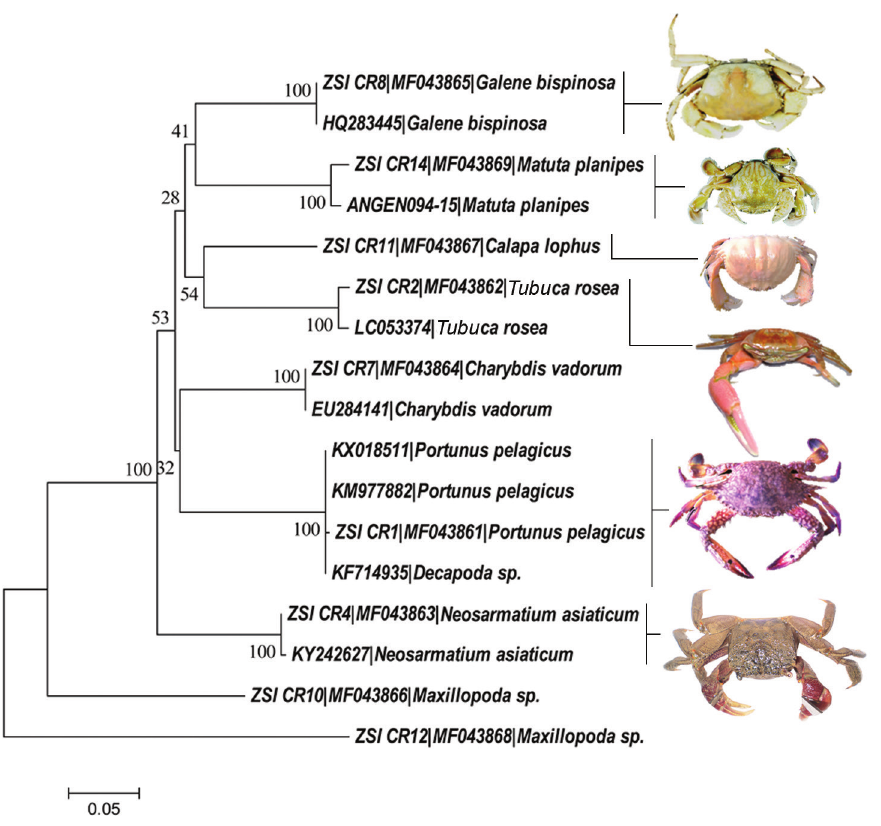
Figure 2: Neighbour-Joining tree of the studied crab species. Bootstrap supports are mentioned in each node. Voucher IDs, GenBank accession numbers, and species name are indicated within parentheses. Photographs of Crab species taken by the first author are superimposed on the